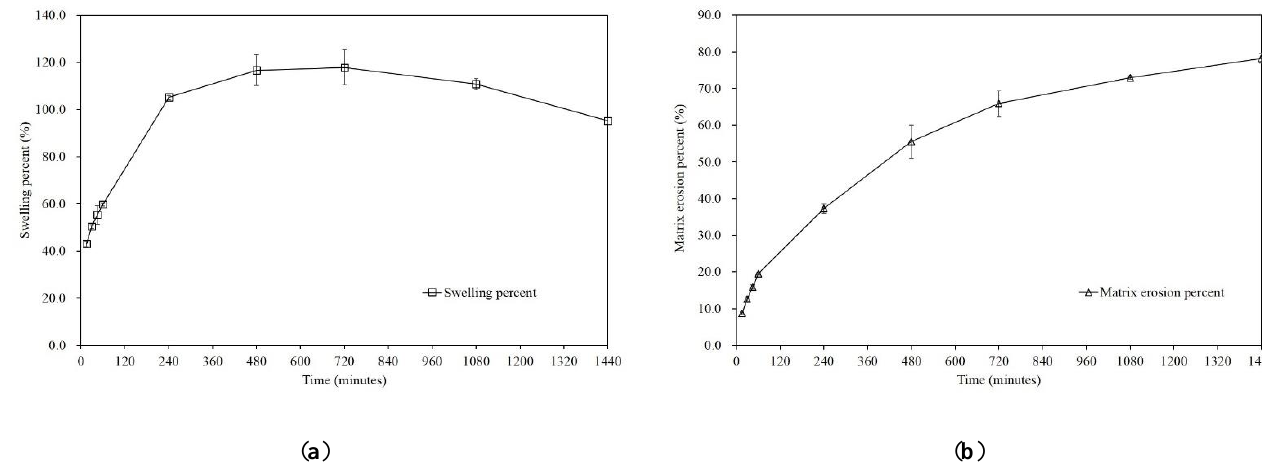
Figure 5. Percentage of (a) swelling and (b) matrix erosion for tablets with the optimized formulations (mean ± SD, n = 3).